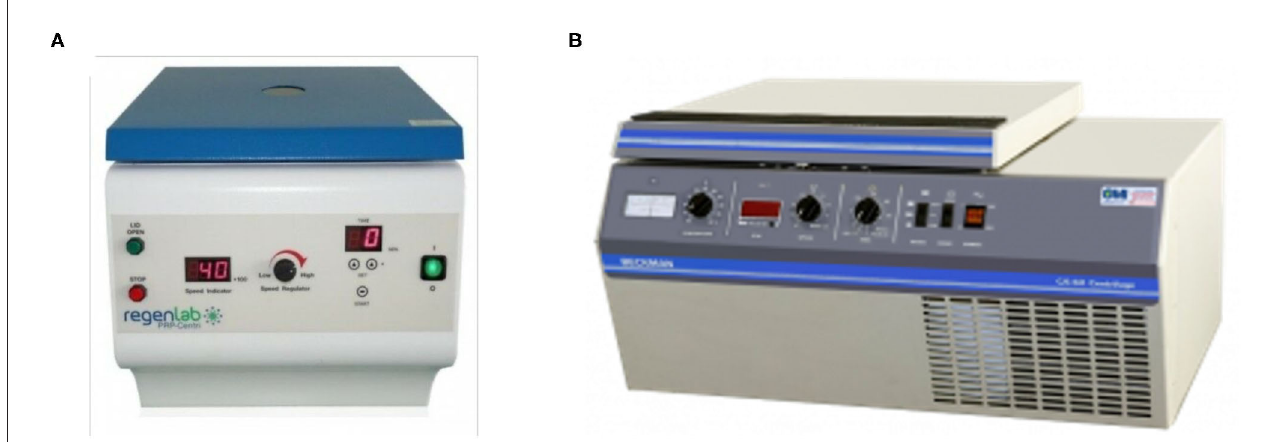
FIGURE 1 | (A) RegenLab PRP-Centri CH-1052 centrifuge used in processing the PRP in cylinder tubes and (B) Beckman CS-6R centrifuge used in processing PRP in a Wheaton